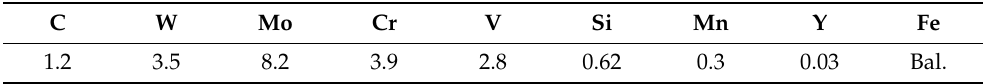
Table 1. Chemical composition of steel (wt%).